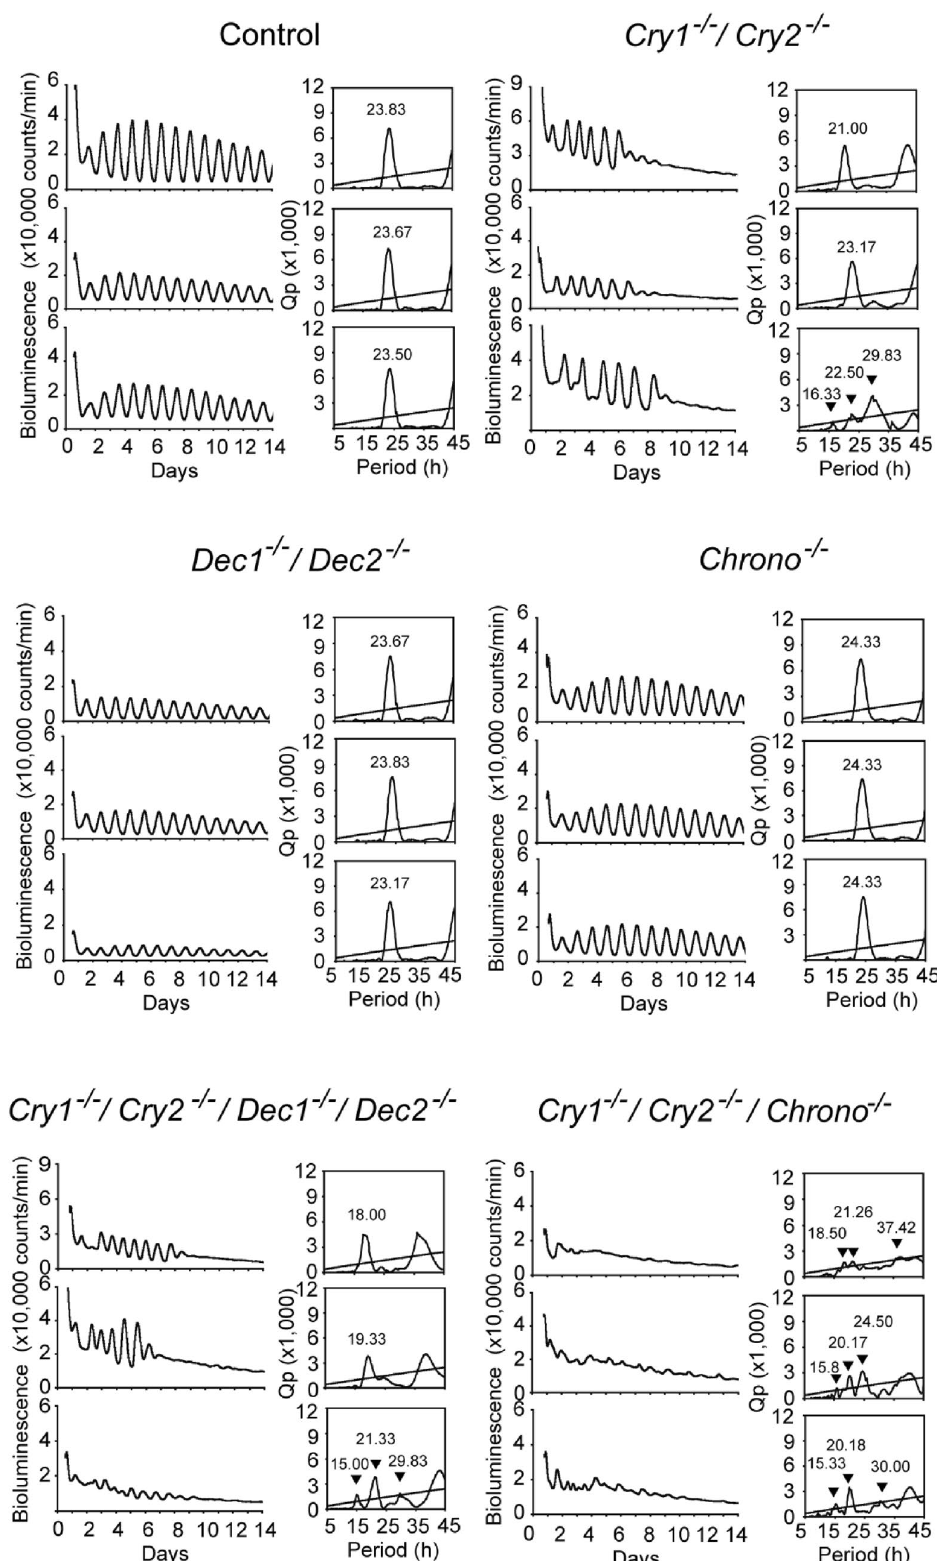
Figure 2. PER2::LUC rhythms of the neonatal SCN slice culture in different genotypes. PER2::LUC rhythms in the neonatal SCN of different genotypes. Three representative rhythms are shown. Genotypes are indicated in each panel. Chi square periodograms for each rhythm in the panel of the left column. The oblique line in the peridogram indicates a significant level of P = 0.01. Triangles and numbers are the peak period of each